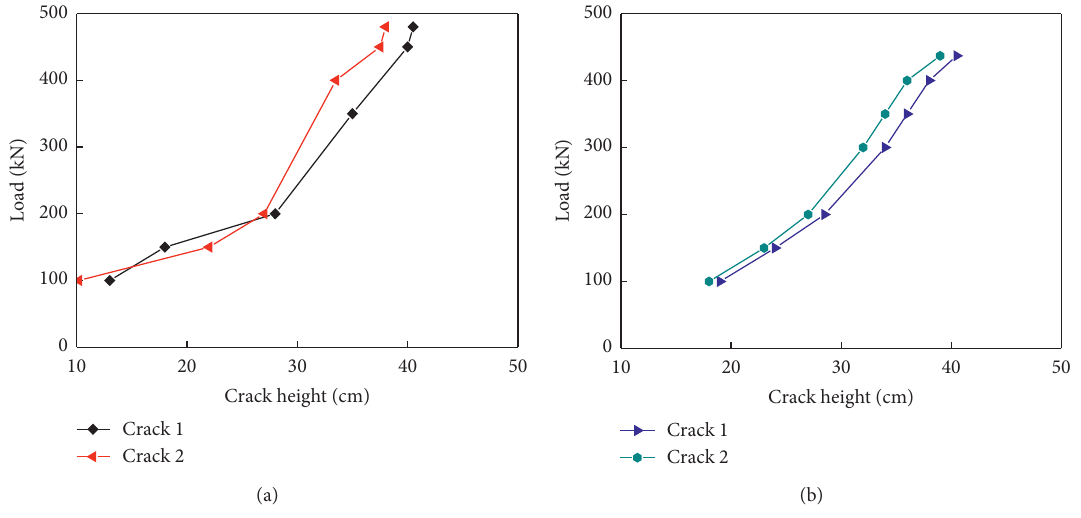
Figure 15: Load-crack height curves: (a) JD1; (b)